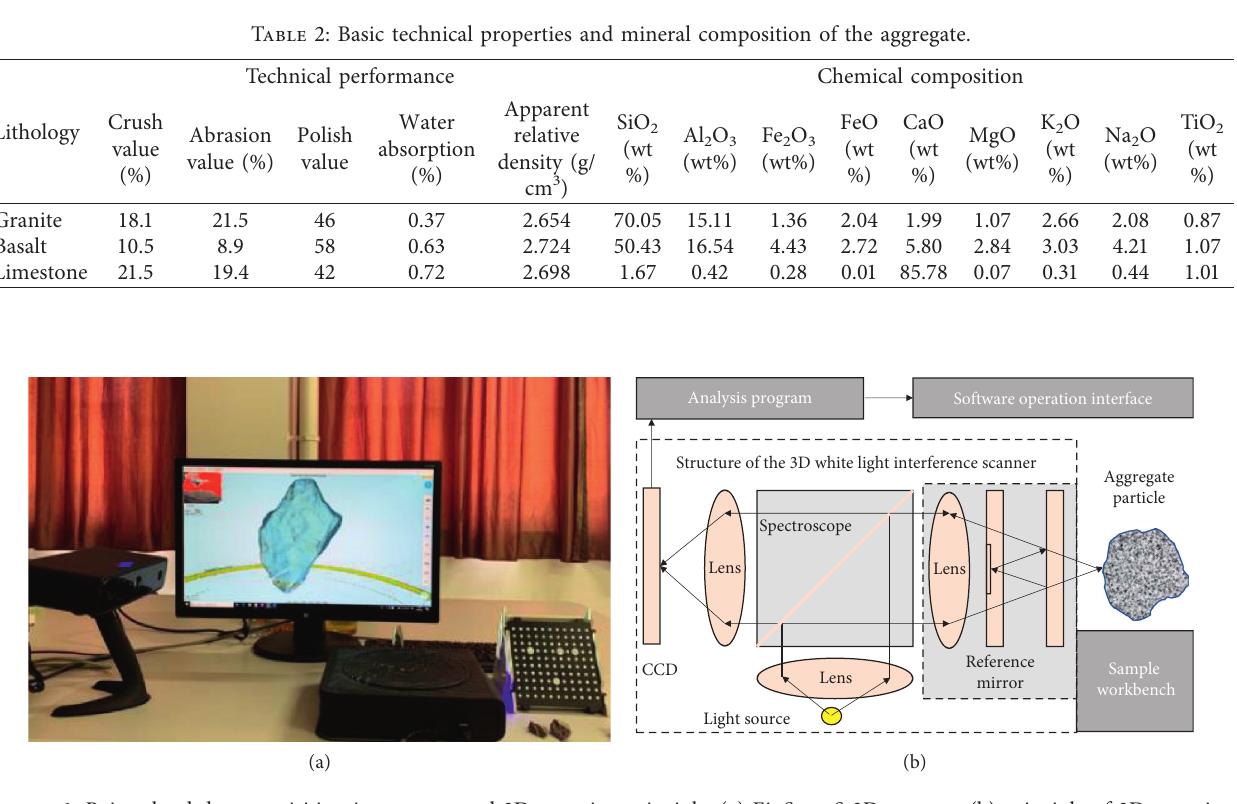
Figure 1: Point cloud data acquisition instrument and 3D scanning principle: (a) EinScan-S 3D scanner; (b) principle of 3D scanning technology.